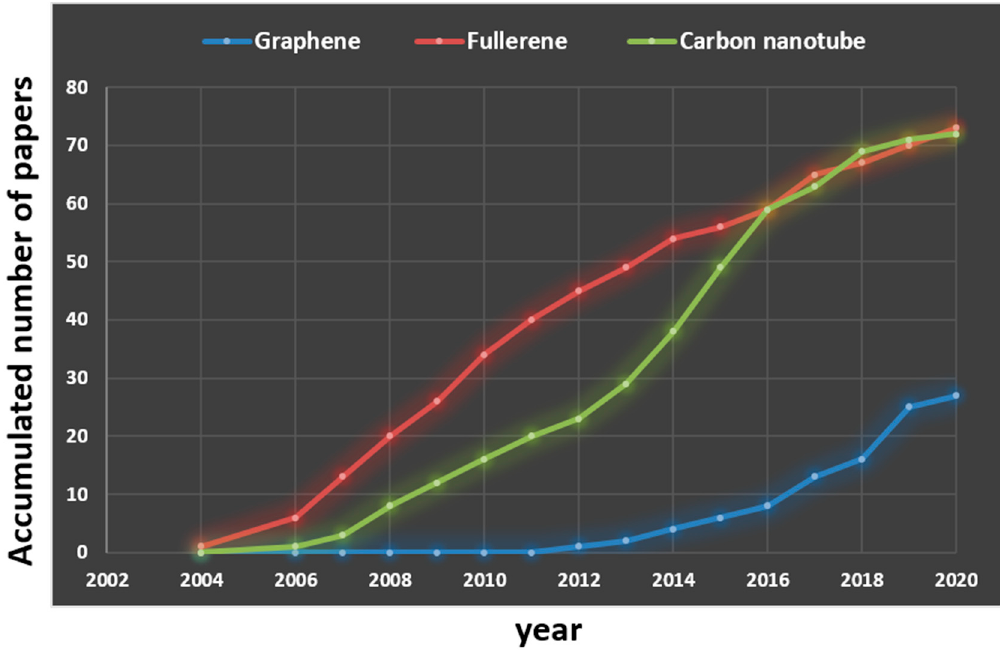
Figure 3. Comparison of paper publication number related to aquatic toxicity induced by three carbon-based nanomaterials during the past 16 years (from 2004 to 2020). Papers relevant to graphene-based nanomaterials are highlighted with blue color. Papers relevant to fullerene-based nanomaterials are highlighted with red color. Papers relevant to carbon nanotube are highlighted with green color.